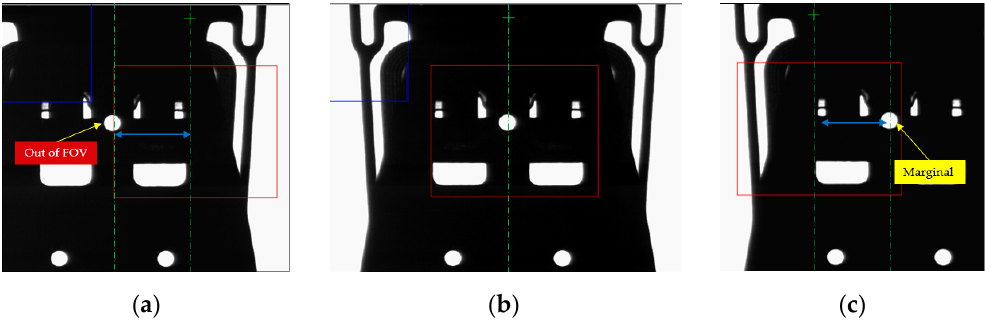
Figure 4. Reference hole positions: ( a ) fault condition, ( b ) nominal position, ( c ) marginal position.